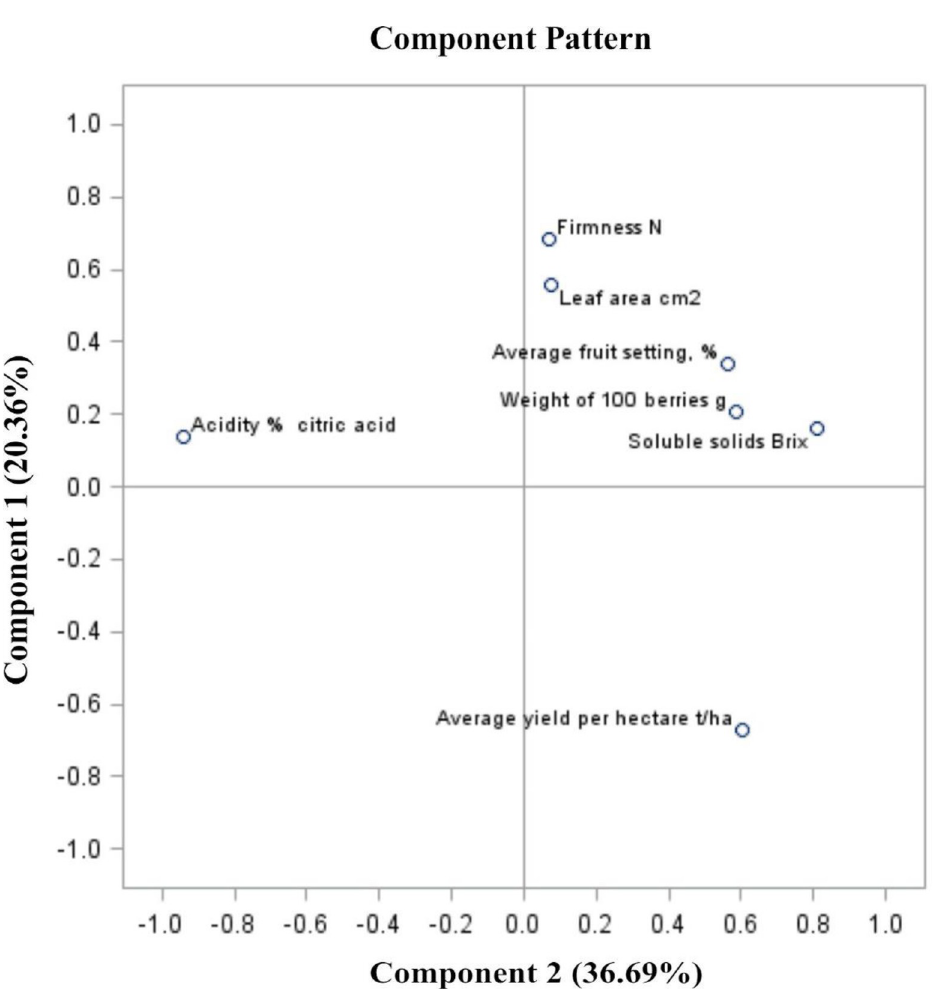
Fig 4. PCA analysis of blueberry fruit in relation to the parameters of the size and quality of the crop in 2020. [component 1, 2].